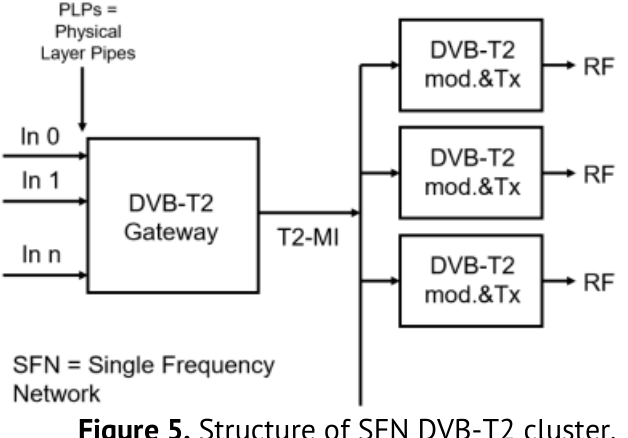
Figure 5. Structure of SFN DVB-T2